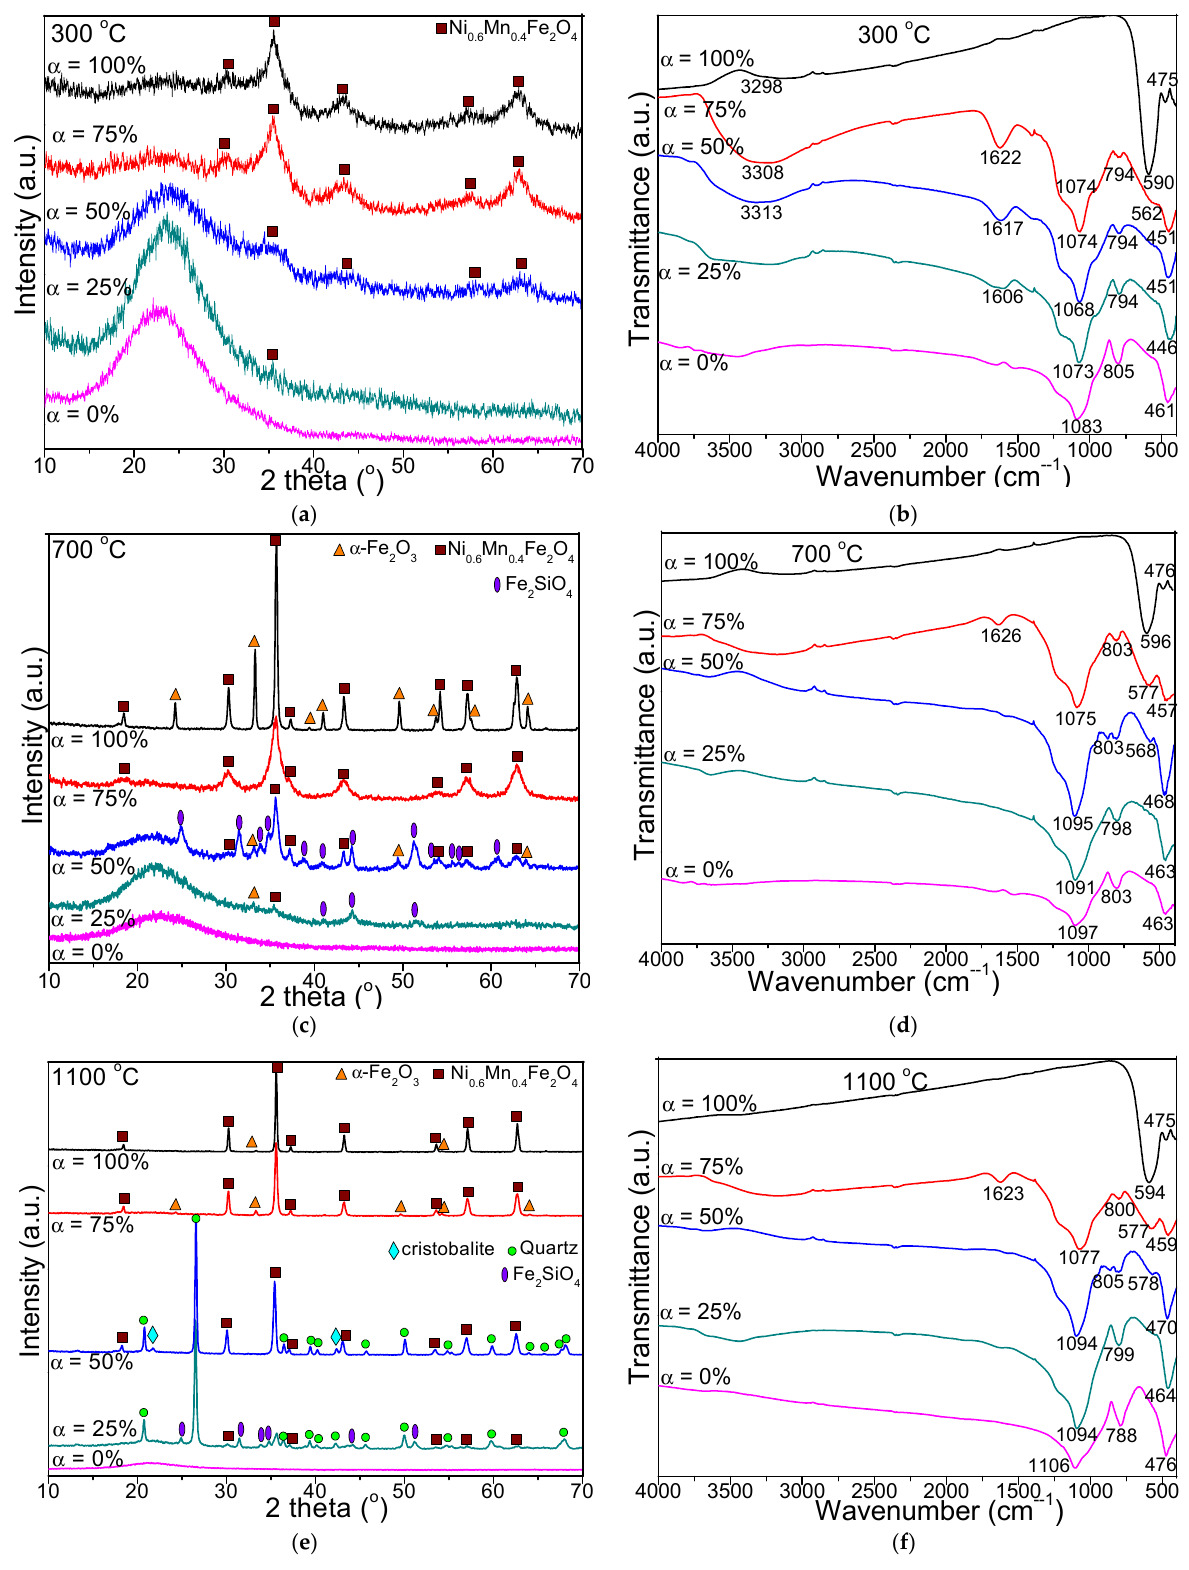
Figure 1. XRD patterns ( a , c , e) and FT-IR spectra ( b , d , f ) of (Ni 0 . 6 Mn 04 Fe 2 O 4 ) α (SiO 2 ) 100 −α ( α = 0–100%) NCs calcined at 300, 700, 1100 °C. As the ferrite content decreases, in NCs with α = 25 and 50%, besides Ni 0 . 6 Mn 04 Fe 2 O 4 , the presence of α -Fe 2 O 3 and Fe 2 SiO 4 (JCPDS card no. 87-0315 [12]) secondary phases is also noticed. We assume that the formation of Fe 2 SiO 4 could be related to difficulty of oxygen diffusion from the pores of SiO 2 matrix and partial reduction of Fe 3+ into Fe 2+ , which reacts with the SiO 2 matrix and forms Fe 2 SiO 4 under the reducing condition produced by the decomposition of carboxylate precursors.